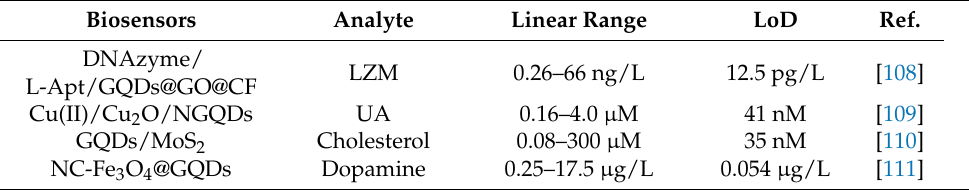
Table 3. Summary of the GQD nanocomposites for CL-based biosensing